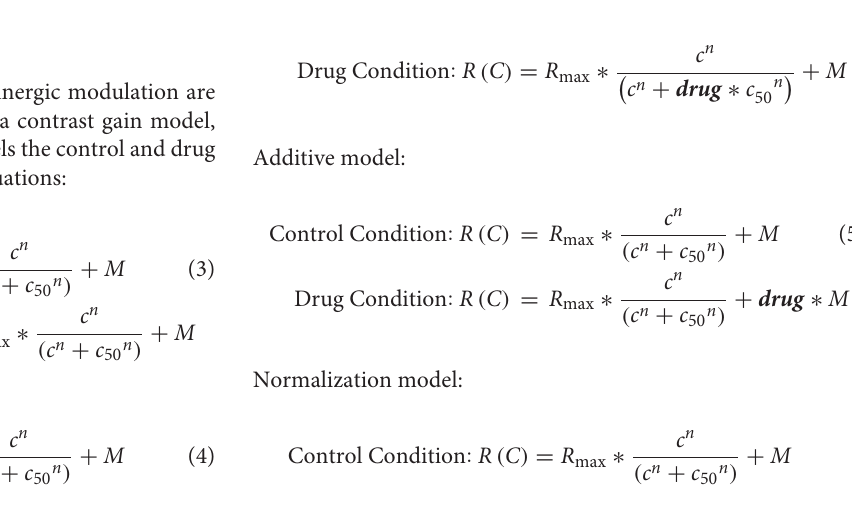
FIGURE 3 | Raw and normalized population histograms of drug effects on neuronal activity across different stimulus contrast. (A) Population activity under control conditions (blue) and when scopolamine was locally applied (red). Upper row shows non-normalized population activity, lower row shows normalized population activity (normalized to maximum for each cell). (B) Population activity under control conditions (blue) and when mecamylamine was locally applied (red). Upper row shows non-normalized population activity, lower row shows normalized (for each cell) population activity. Solid lines show mean activities, shaded areas S.E.M (which sometimes was too small to be